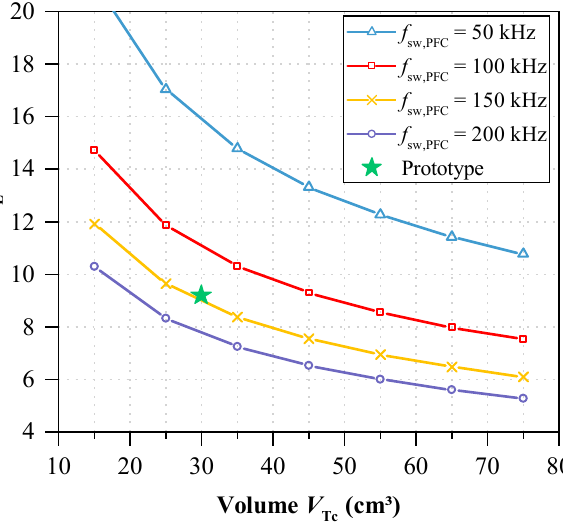
Figure 10. Loss P L versus volume V Tc of the PFC coil for different selected switching frequencies f sw,PFC .